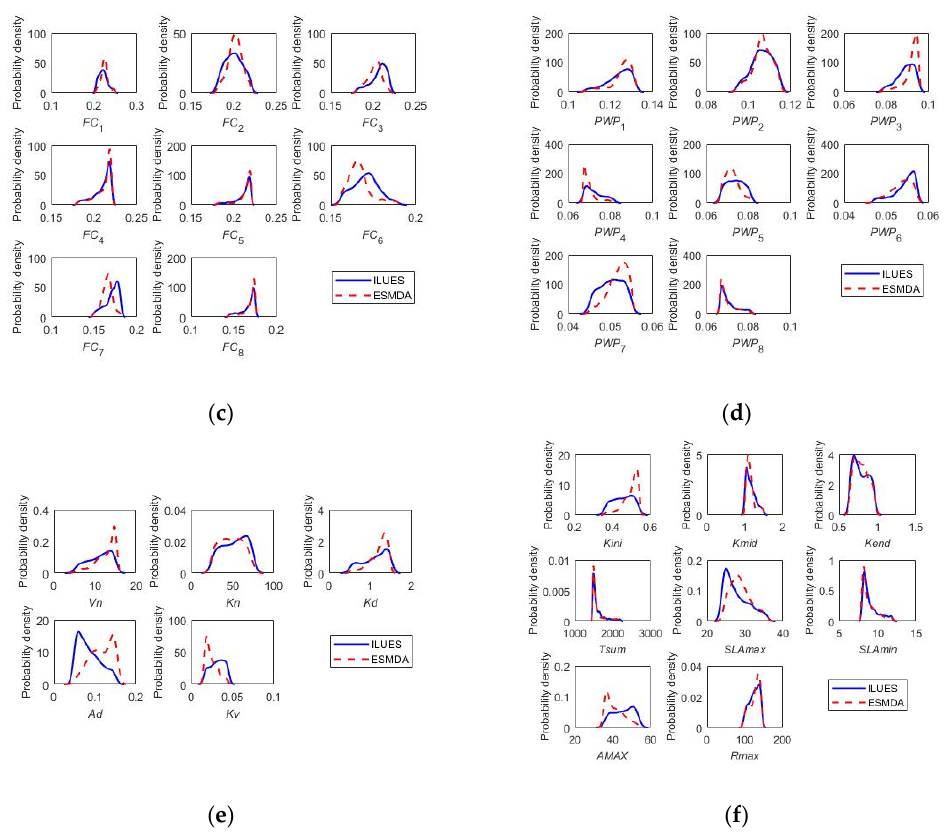
Figure 5. Posterior marginal distributions of model parameters estimated by ILUES (blue lines) and ESMDA (red dashed lines), respectively. ( a ) Ks; ( b ) Saturated soil water content; ( c ) Field capacity; ( d ) Wilting point; ( e ) Nitrogen transformation parameters; ( f ) Crop parameters, for W 2 N 1 listed in Table 3.